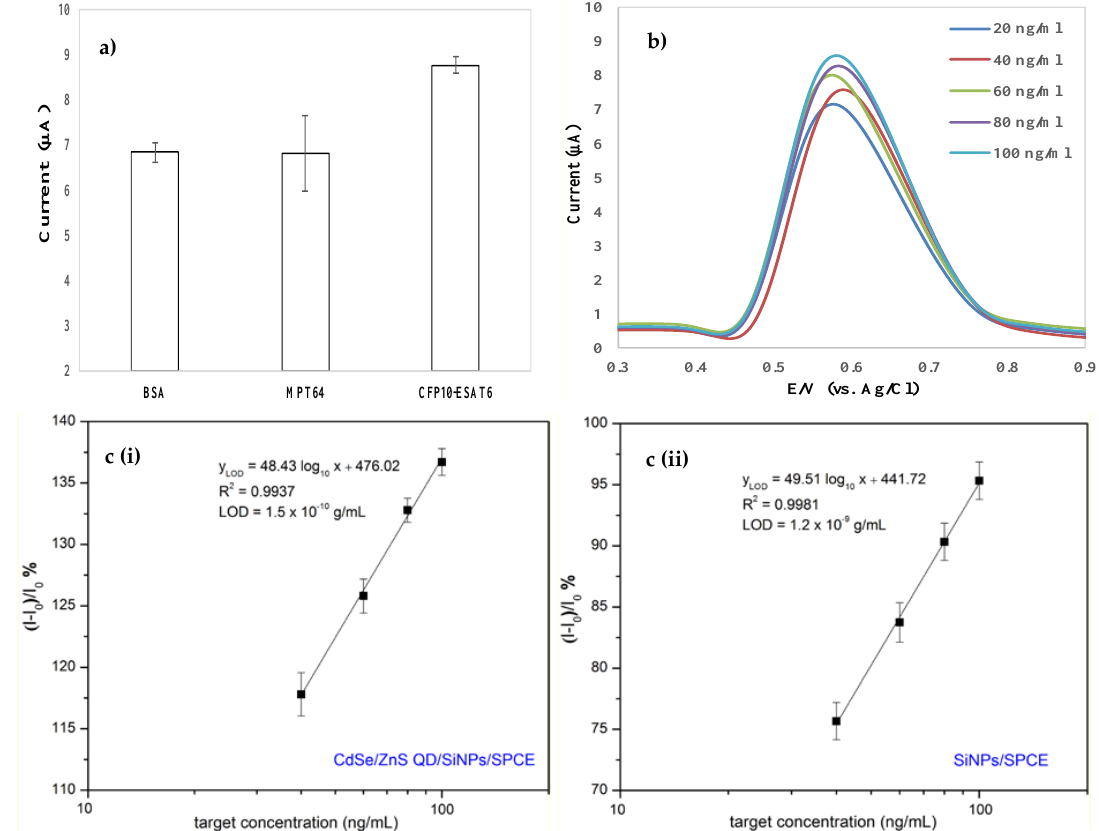
Figure 6. ( a ) Oxidation peak current of H 2 O 2 by using different types of protein (1% BSA, 20 ng/ml MPT64, and 20 ng/mL CFP10 – ESAT6) in 0.1 M PBS (pH 7.4) containing 150 µM H 2 O 2 ; ( b ) DPV